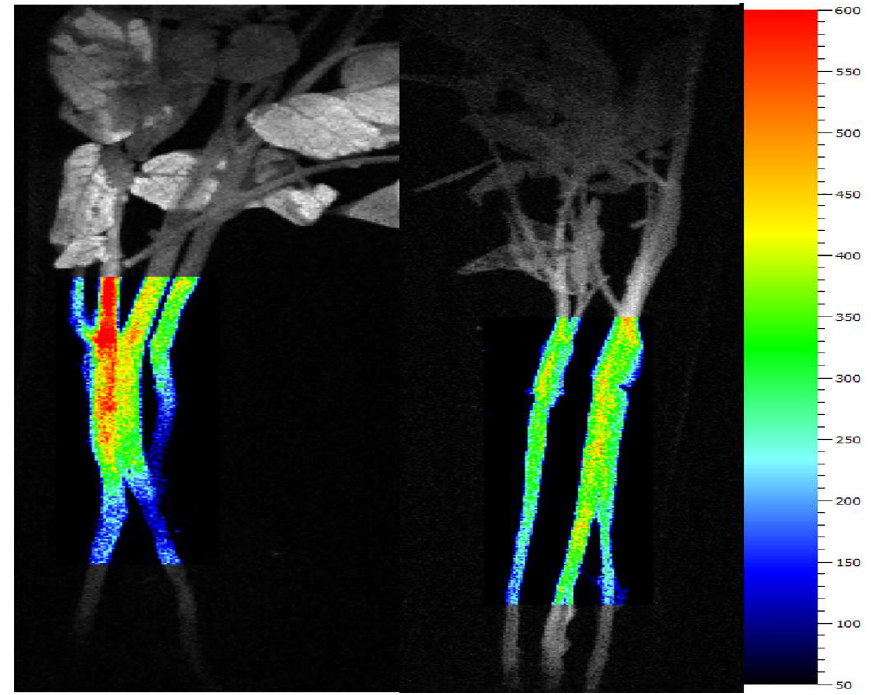
Figure 5. Fluorescence images (F m measurements) of tomato stems of control plants ( left ) and plants with the root apparatus infected by M. incognita root ( right ). As roots do not show chlorophyll emissions, only LIBS spectra were acquired on uninfected and M. incognita -infected root samples. The C emission line is very weak, and two Si I lines appear in the control sample, whereas the intensity of Mg ++ lines was similar for both the control and infected roots (Figure 7). In this study, we used fresh leaves and roots, although the moisture content can greatly affect spectral features. In particular, as moisture content increases, many emission lines decrease markedly or even